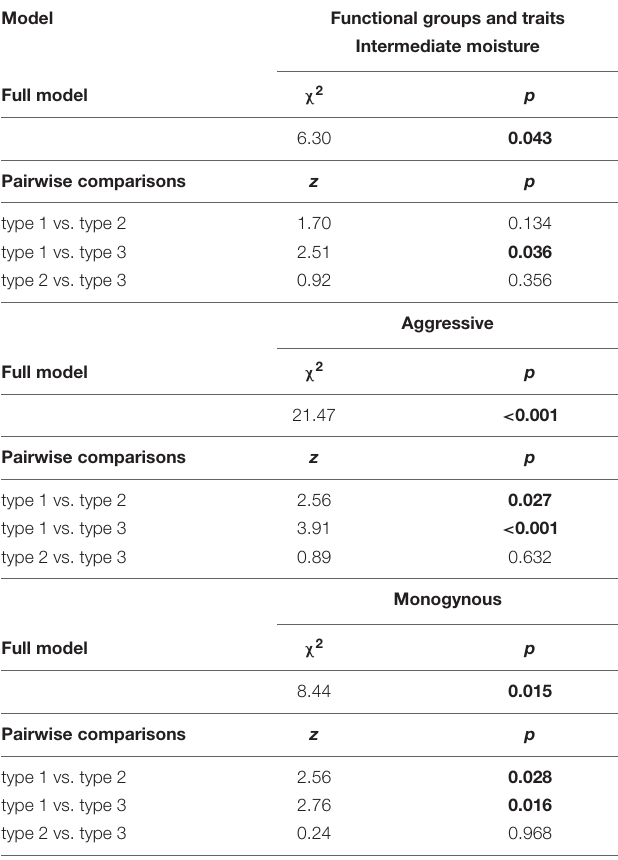
TABLE 3 | Comparisons of ant species occurrences related to different functional groups and traits (see Figure 3 and Table 1 ) in doline types (types 1–3) in the Bükk Mts (Hungary) using the fitted generalized linear mixed-effect models (only statistically significant models are shown).